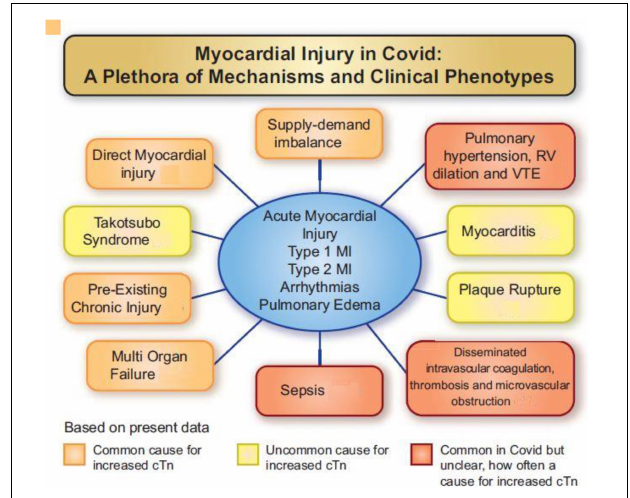
FIGURE 4 | Various mechanisms involved in myocardial injury caused by SARS-CoV-2 viral invasion in humans (48). cTn, cardiac troponin I or T; MI, myocardial infarction; RV, right ventricle; VTE, venous thromboembolism. Source: Jaffe et al. (48). Used with